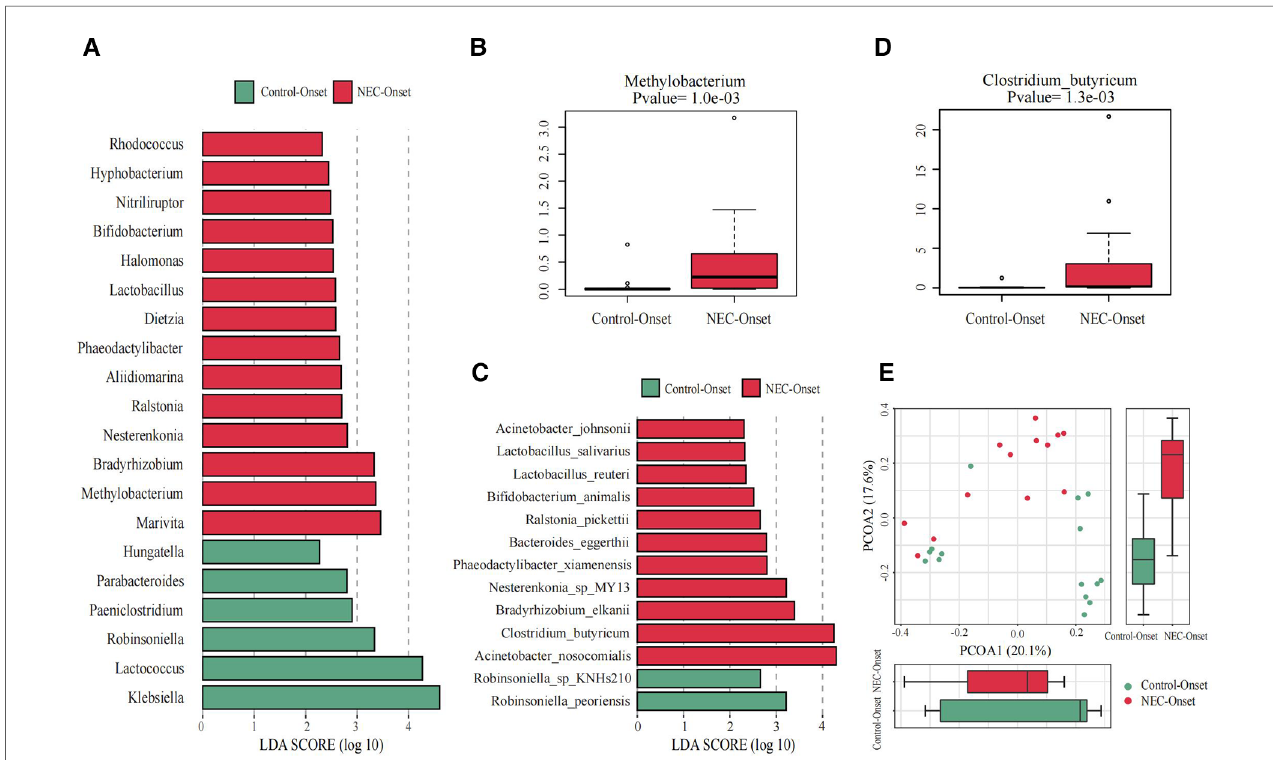
FIGURE 3 Signi fi cant differences in the microbiota and correlation. ( A ) Gut microbiota analysis at the genus level using the LDA score for NEC group infants and control group infants. ( B ) Bar chart of Methylobacterium between the NEC_Onset group and the Control_Onset group. ( C ) Gut microbiota analysis at the species level using the LDA score for NEC group infants and control infants. ( D ) Bar chart of Clostridium_butyricum between the NEC_Onset group and the Control_Onset group. ( E ) Principal coordinate analysis (PCoA) of the microbial communities of the two groups. The microbiota cluster in the infants of the NEC_Onset group (red circle) and the Control_Onset group (green circle) was examined by using PCoA. NEC, necrotizing enterocolitis; LDA, linear discriminant